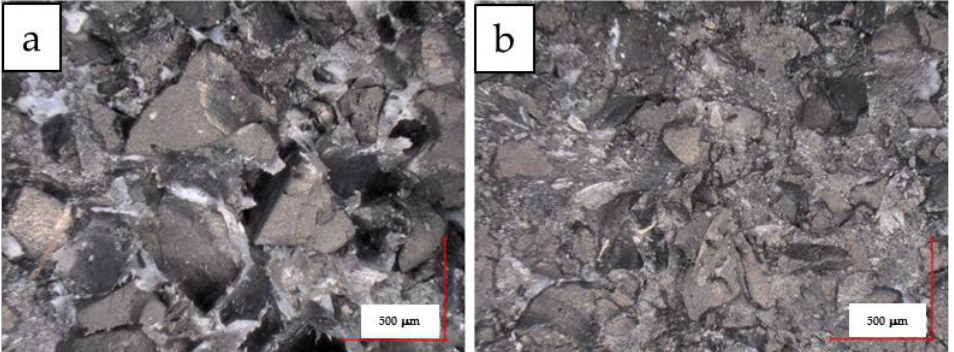
Figure 18. Photography of a fracture test (tensile test) of PP-GTR moldings: PP/GTR50 ( a ), PP/GTR50-P ( b ).